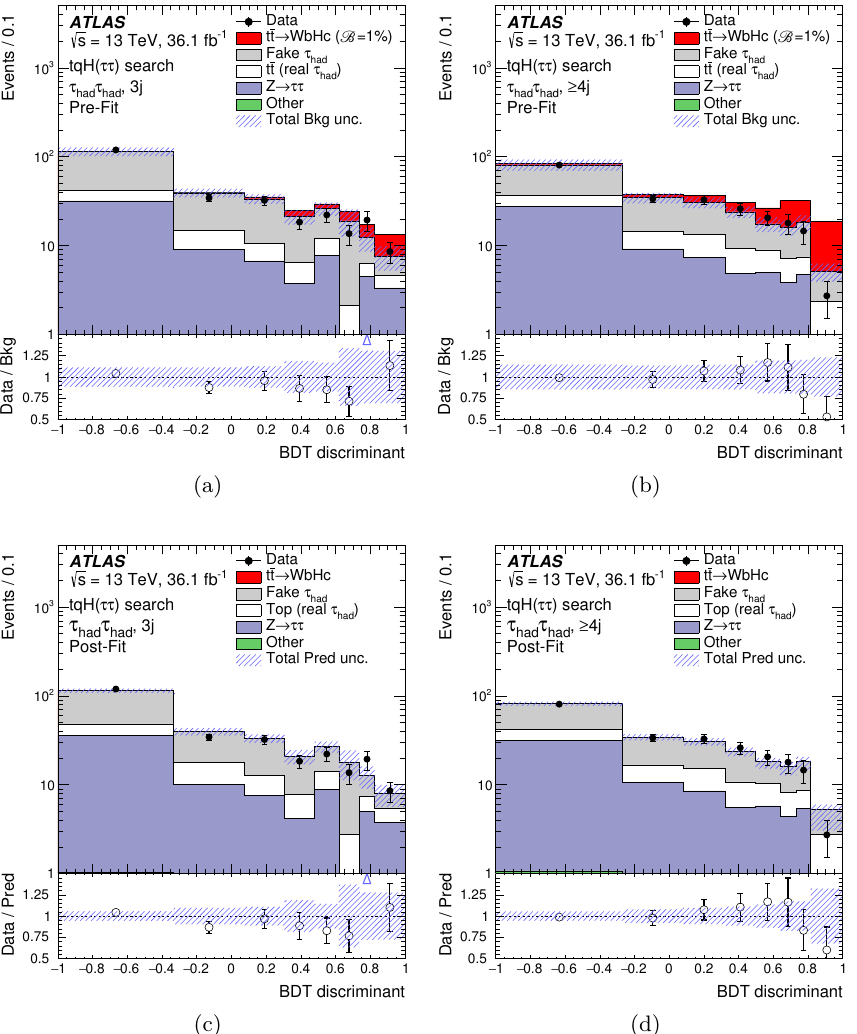
Figure 10 . tqH ( (cid:28)(cid:28) ) search: comparison between the data and prediction for the BDT discriminant distribution in the (cid:28) had (cid:28) had channel, before and after the (cid:12)t to data (\Pre-Fit" and \Post-Fit", respectively) under the signal-plus-background hypothesis. Shown are the ( (cid:28) had (cid:28) had , 3j) region (a) pre-(cid:12)t and (c) post-(cid:12)t, and the ( (cid:28) had (cid:28) had , (cid:21) 4j) region (b) pre-(cid:12)t and (d) post-(cid:12)t. The contributions with real (cid:28) had candidates from t (cid:22) t , t (cid:22) tV , t (cid:22) tH , and single-top-quark backgrounds are combined into a single background source referred to as \Top (real (cid:28) had )", whereas the small contributions from Z ! ‘ + ‘ (cid:0) ( ‘ = e; (cid:22) ) and diboson backgrounds are combined into \Other". In the pre-(cid:12)t (cid:12)gures the expected t (cid:22) t ! WbHc signal (solid red) corresponding to B ( t ! Hc ) = 1% is also shown, added to the background prediction. In the post-(cid:12)t (cid:12)gures, the t (cid:22) t ! WbHc signal is normalised using the best-(cid:12)t branching ratio, B ( t ! Hc ) = ( (cid:0) 4 : 4 +9 : 9 ) (cid:2) 10 (cid:0) 4 . The bottom panels display the (cid:0) 8 : 5 ratios of data to either the SM background prediction before the (cid:12)t (\Bkg") or the total signal-plus- background prediction after the (cid:12)t (\Pred"). The blue triangles indicate points that are outside the vertical range of the (cid:12)gure. The hashed area represents the total uncertainty of the background. In the case of the pre-(cid:12)t background uncertainty, the normalisation uncertainty of the fake (cid:28) had background is not included.